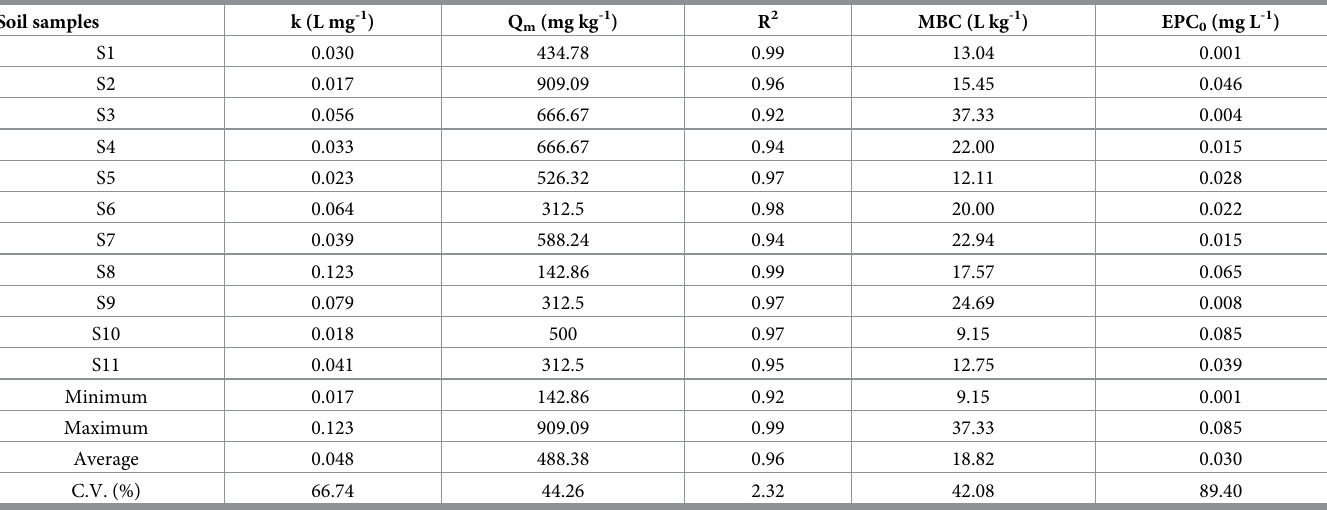
� Information of eleven soils see Table 1. Q m , phosphorus sorption maximum; EPC0, the equilibrium phosphorus concentration at zero adsorption; MBC, the maximum adsorption buffering capacity; k, a constant related to the binding energy. C.V., Coefficient of